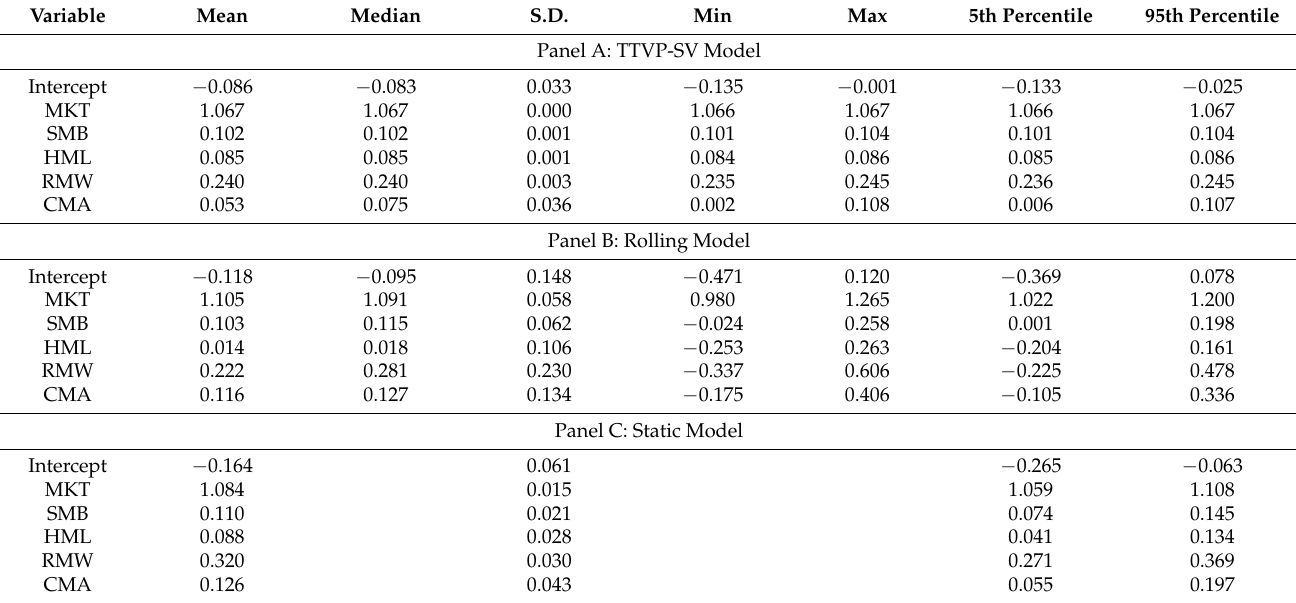
Table 3. Time varying, rolling and static factor betas—Manufacturing.